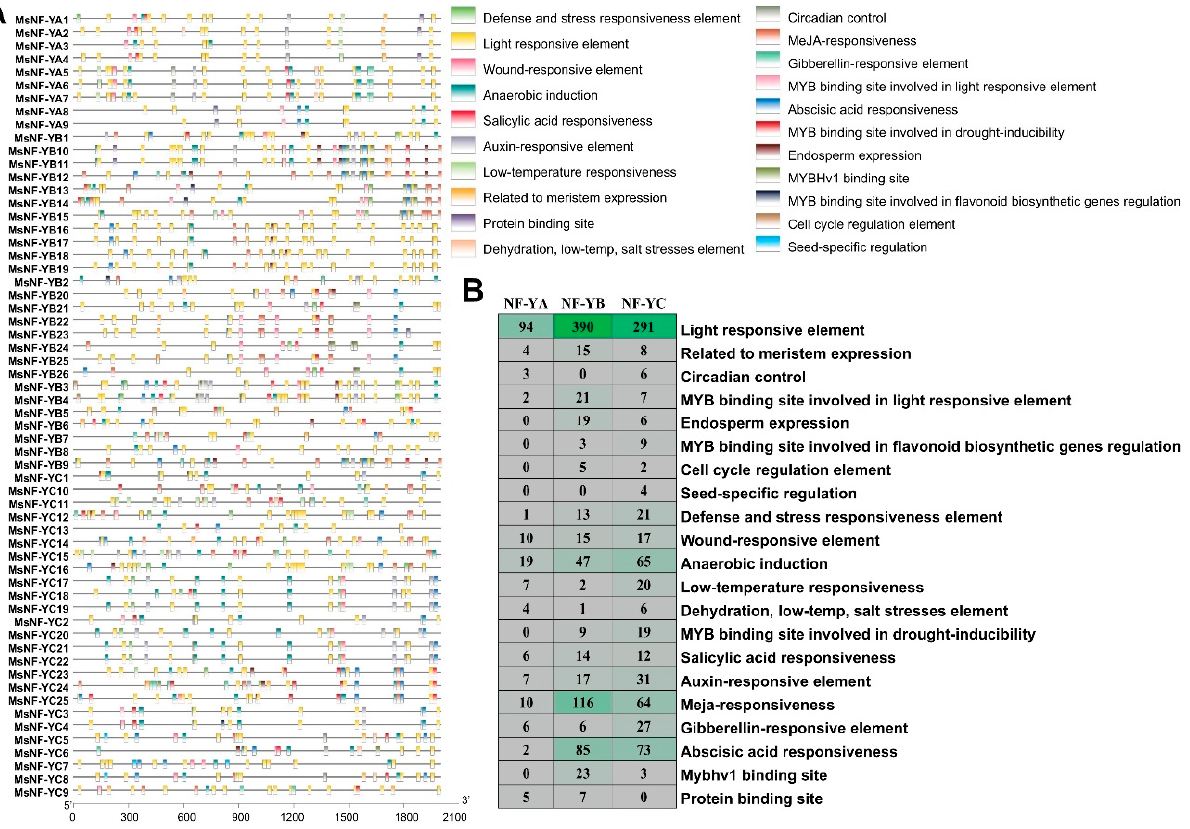
Figure 5. cis -element analysis of the 60 MsNF-Ys promoter regions. ( A ) The locations of these cis elements in the MsNF-Y promoter regions; the boxes with different colors indicate different cis elements. ( B ) Statistical analysis of different types of cis elements.